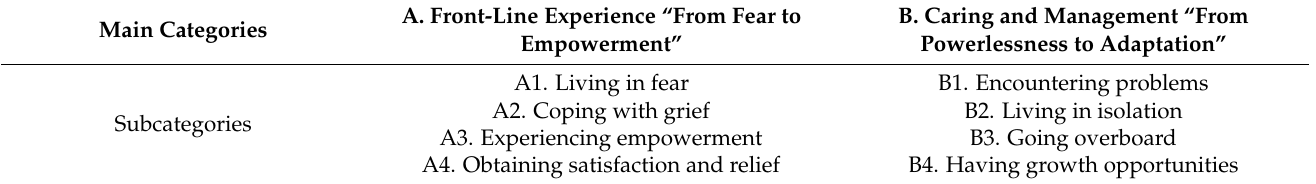
Table 2. Main categories and subcategories that emerged from the analysis of